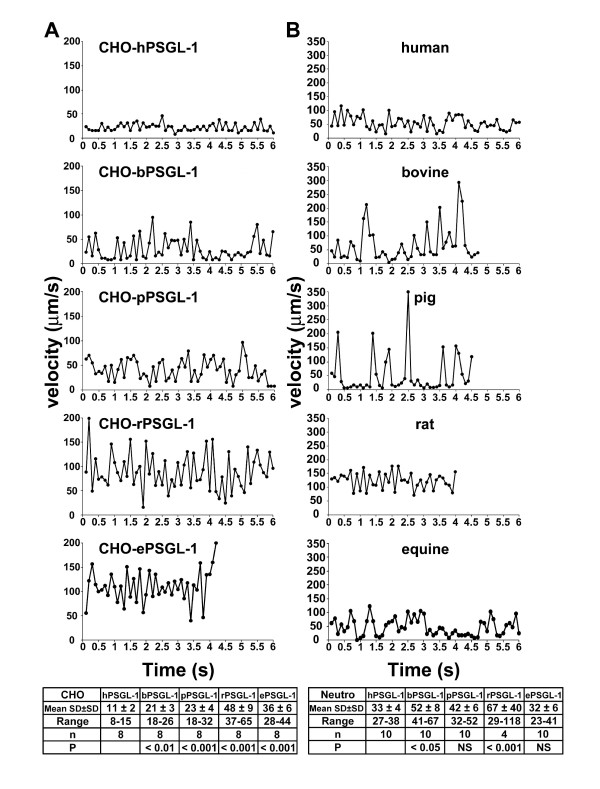
Stability of rolling velocities of CHO-PSGL-1 transfectants or mammalian neutrophils on human L-selectin. Frame-by-frame rolling velocities of (A) CHO-PSGL-1 transfectants or (B) human, bovine, pig, rat or equine neutrophils on human L-selectin. The velocity of tracked cells was determined by measuring cell displacements within successive video frames (0.1 ms) in the flow direction under a shear stress of 1.0 dyne/cm2. Cells were tracked for 4 to 6 s. Data are representative of 4–10 experiments.